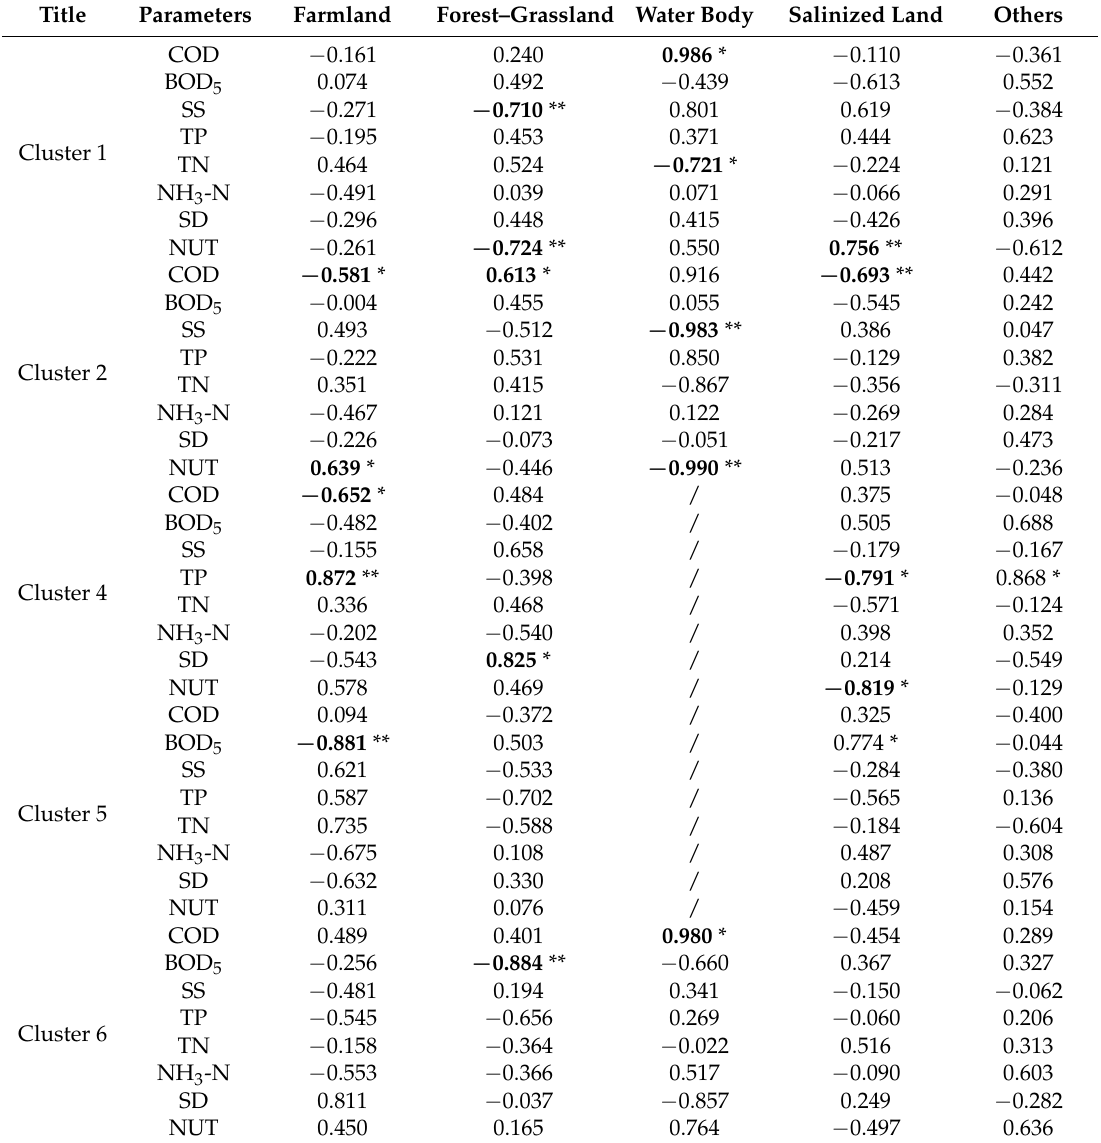
Table 3. The correlation coefficients between the land use/cover and water quality parameters in each